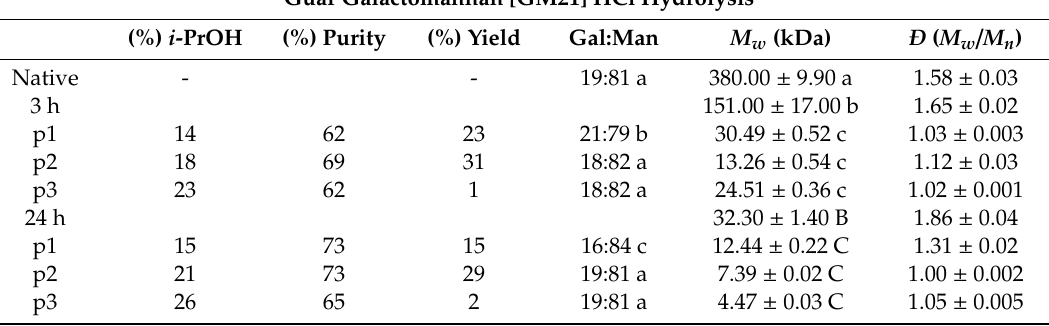
Table 2. M w and Ð variation of GM21 during 3 and 24 h acid hydrolysis before and after i -PrOH precipitation, with p1, p2, and p3 being the polysaccharide fractions collected during stepwise addition of i -PrOH #